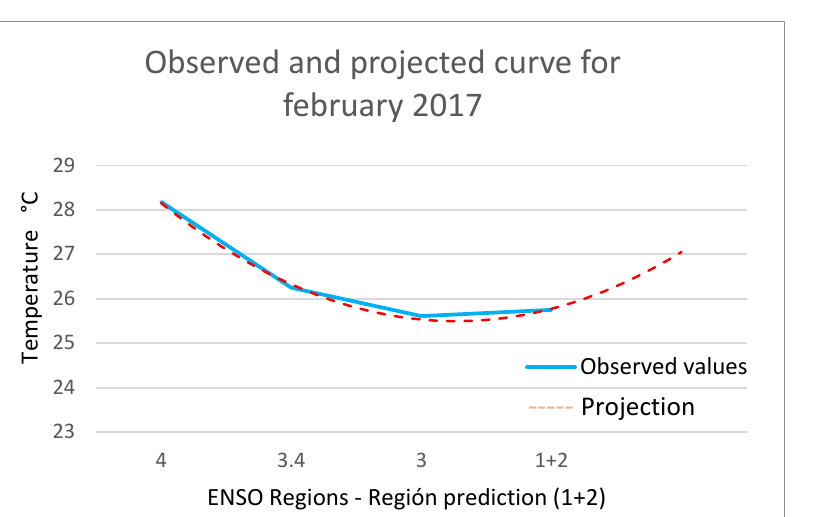
Figure 11. Example of the sea surface temperature (SST) projection for zone 1 + 2 (Niño Costero) for the month of February.